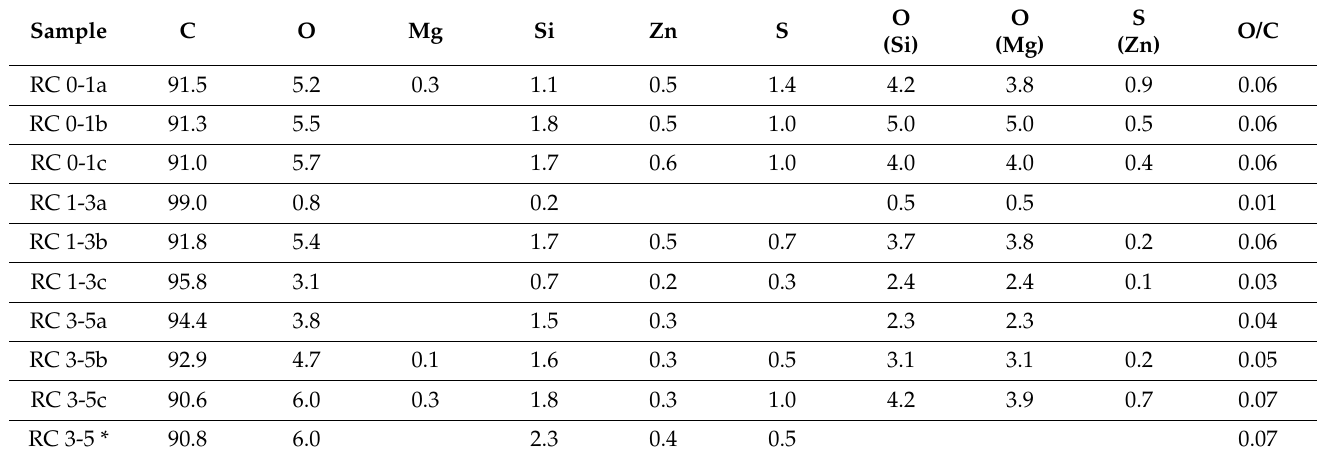
Table 2. XPS surface elemental composition of rubber crumb samples